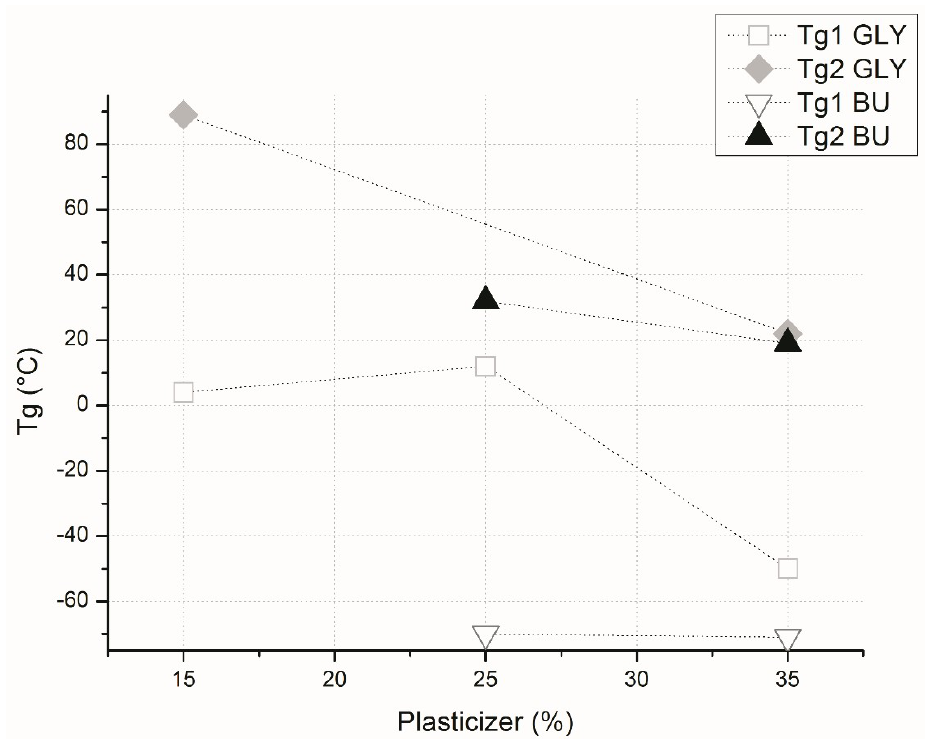
Figure 1. Glass transition temperatures of the materials vs. plasticizer content. Two glass transition temperatures were present in the materials: the lower one is plotted as T g 1, while the higher one is plotted as T g 2 for both glycerol and 1,4-butanediol.